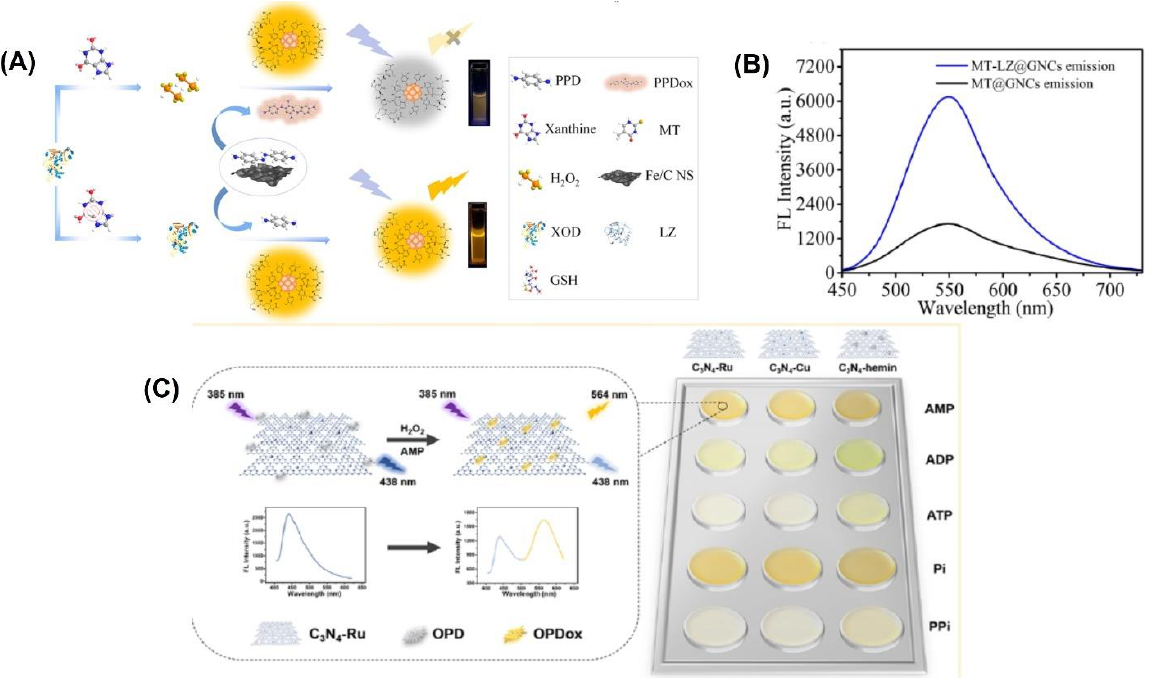
Figure 4. ( A ) Schematic representation of the fabrication of MT-LZ@GNCs. ( B ) Fluorescence emission spectra of MT@GNCs and MT-LZ@GNCs. ( C ) Schematic representation of the principle behind the assay and the color change obtained with the three different materials. Reprinted with permission from refs. [51,105].